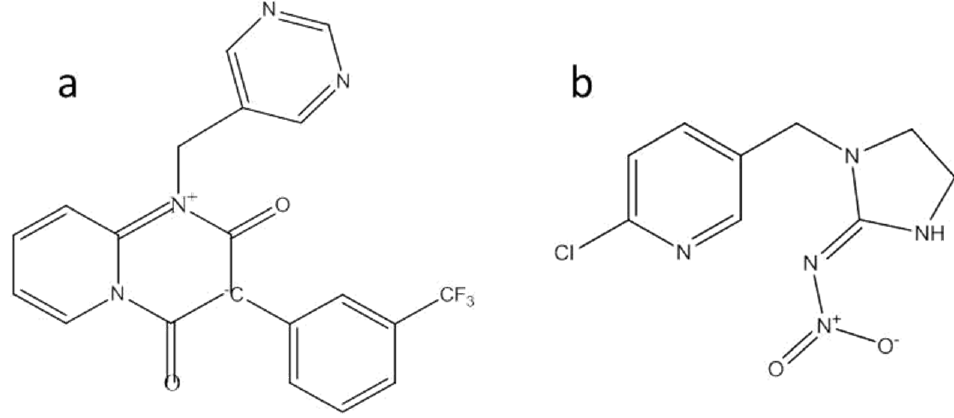
Figure 1. Chemical structure of triflumezopyrim (a) and imidacloprid (b)